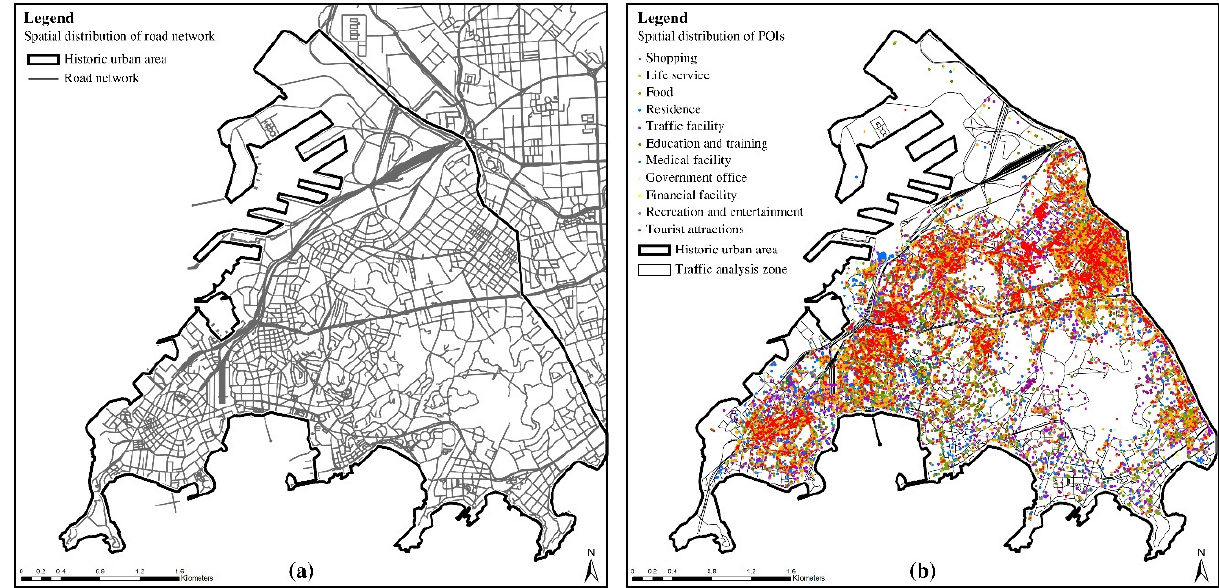
Figure 3. Required dataset type. (a) Road network distribution. (b) POIs distribution.